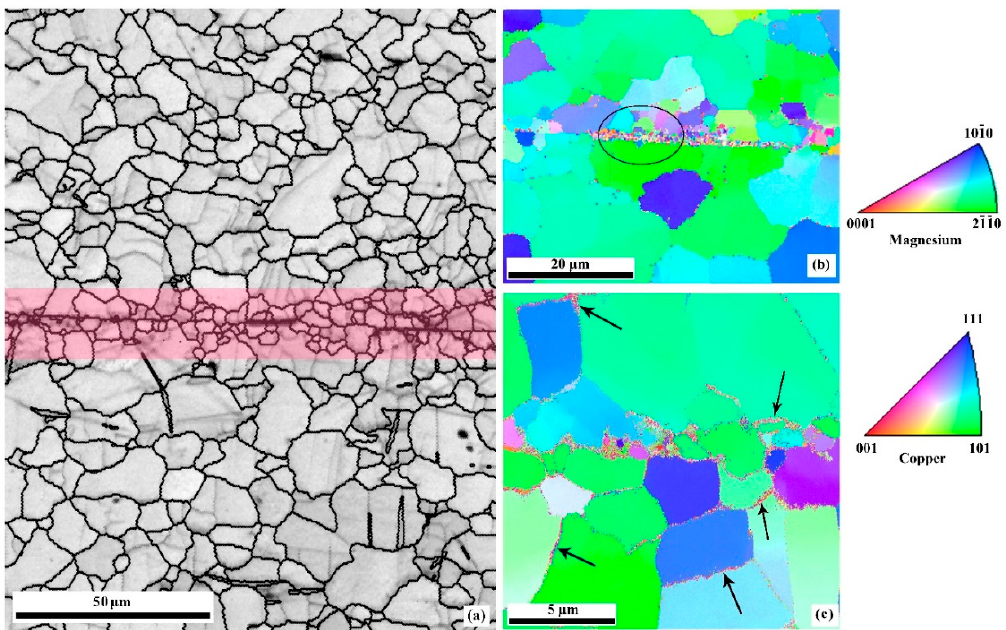
Figure 12. EBSD analysis on joint type B (1100 J), for ( a ) low magnification phase map with grain boundaries, ( b ), and ( c ) IPF colored map of interface in different magnifications.